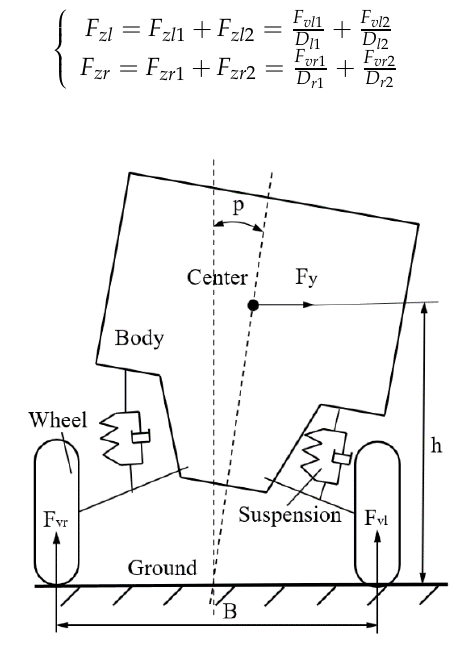
Figure 4. Vehicle rollover diagram (front view).